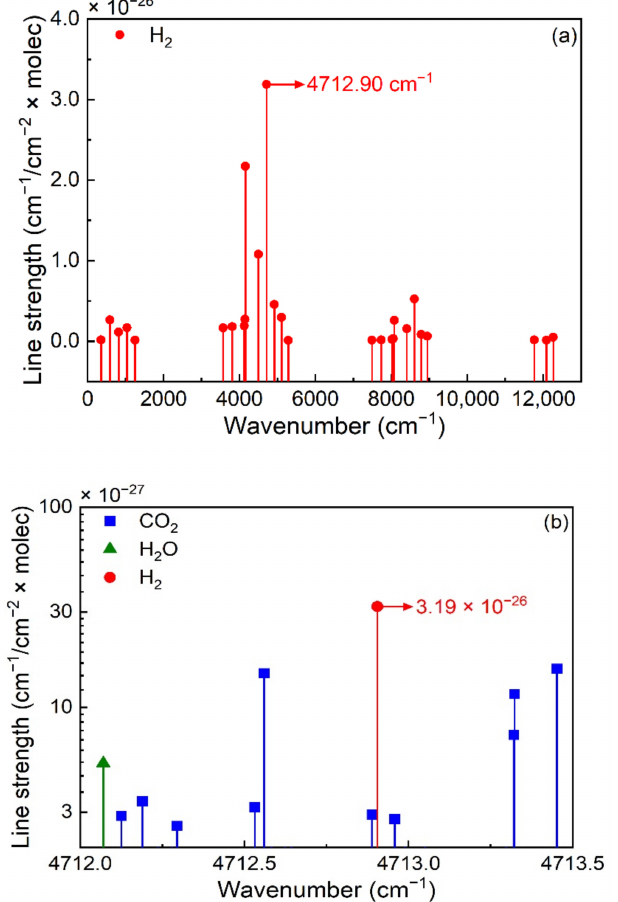
Figure 1. Simulations of line strength based on the HITRAN 2020 database. ( a ) All absorption lines of H 2 . ( b ) The absorption lines of H 2 , CO 2 , and H 2 O between the spectral range of 4712.0 cm − 1 and 4713.5 cm − 1